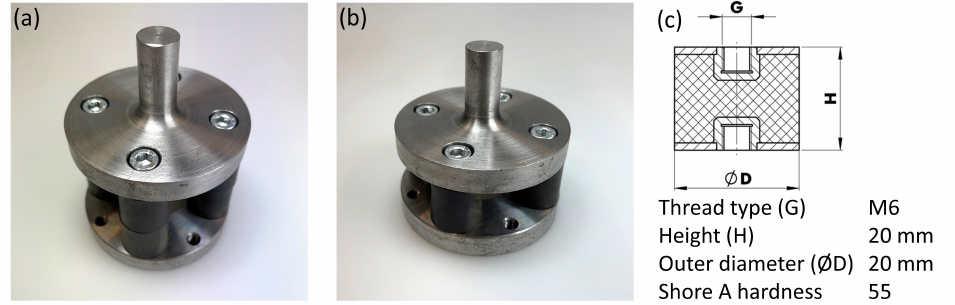
Figure 4. ( a ) Compliant element A with two rubber buffers aligned; ( b ) compliant element B with one rubber buffer aligned; ( c ) size of rubber